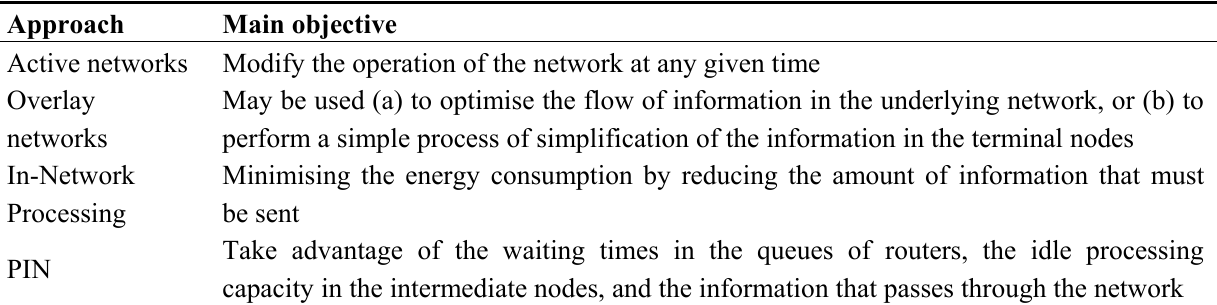
Table 1. Main network processing approaches to date and